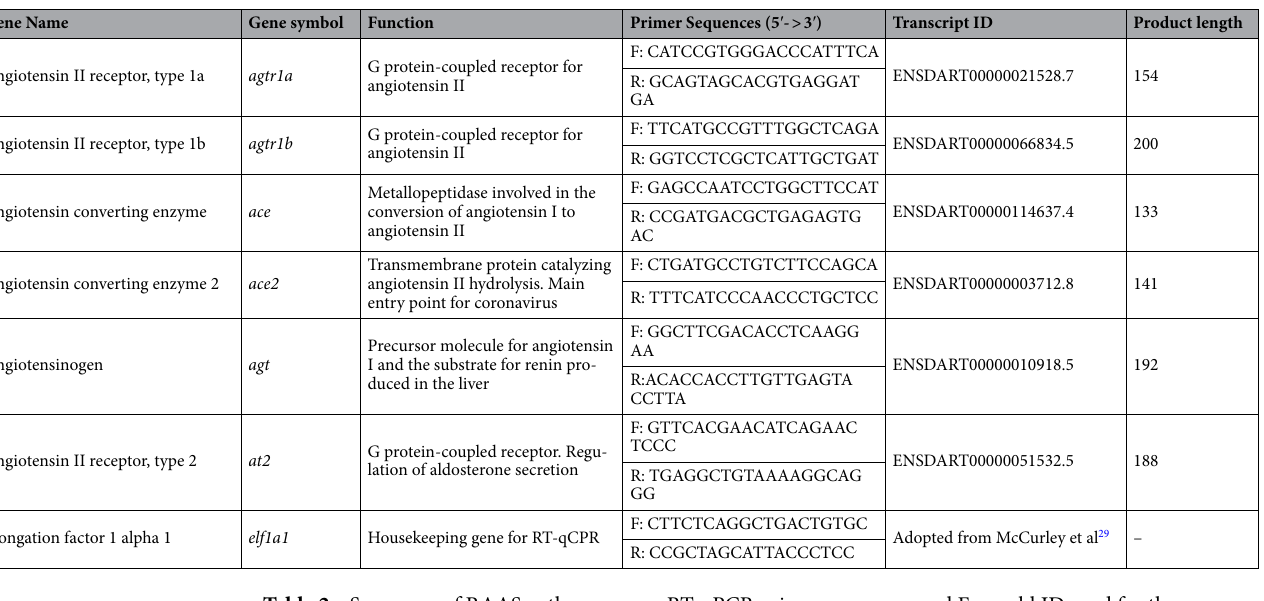
Table 2. Summary of RAAS pathway genes, RT-qPCR primer sequence, and Ensembl ID used for the RT-qPCR